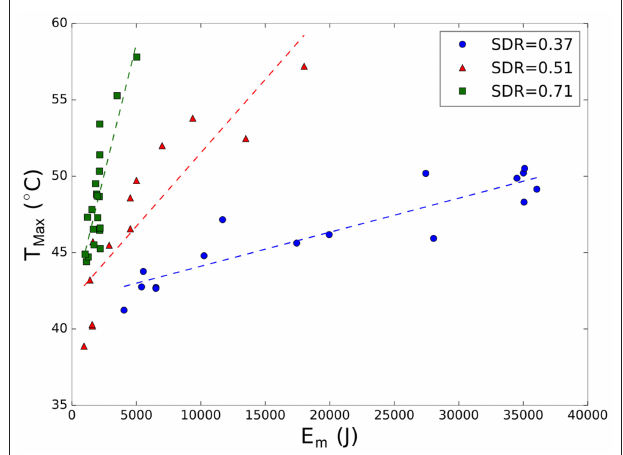
FIGURE 1 | Energy released on the target for various skull density ratio (SDR) values in the four treatment stages (and related temperature ranges). Dashed lines represent spline curves that connect the experimental data, and continuous lines represent the best fit curves (more information is provided in Table S2 ). For low SDR range (0.35–0.4), the measured energy values for the treatment stage III are higher than those for treatment stage IV because we were unable to achieve an increase in temperature of above 55 ◦ C in six patients, even by increasing the planned energy.